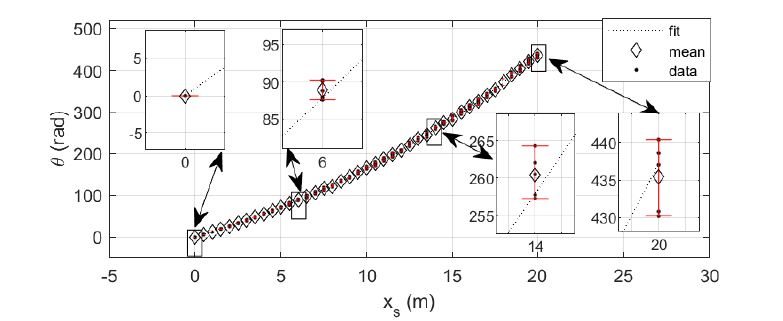
Figure 4. Scenario for obtaining θ ( x ) .